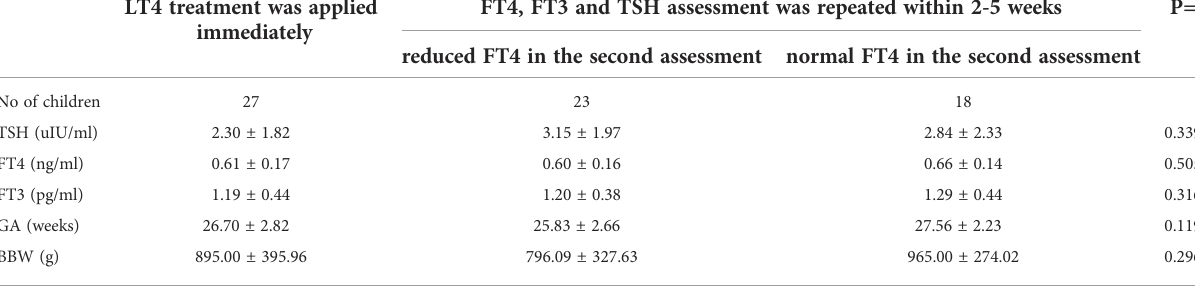
TABLE 5 Mean (± SD) values of screening TSH, FT4 and FT3 serum concentrations in the group of preterm newborns with hypothyroxinemia, depending on the initial therapeutic decision and the results of tests performed thereafter (three PHT children were excluded from the analysis). LT4 treatment was applied